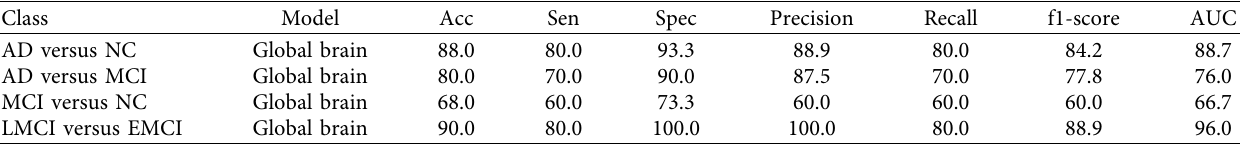
Table 3: Experimental results of adjusting parameters by controlled variable method (%).